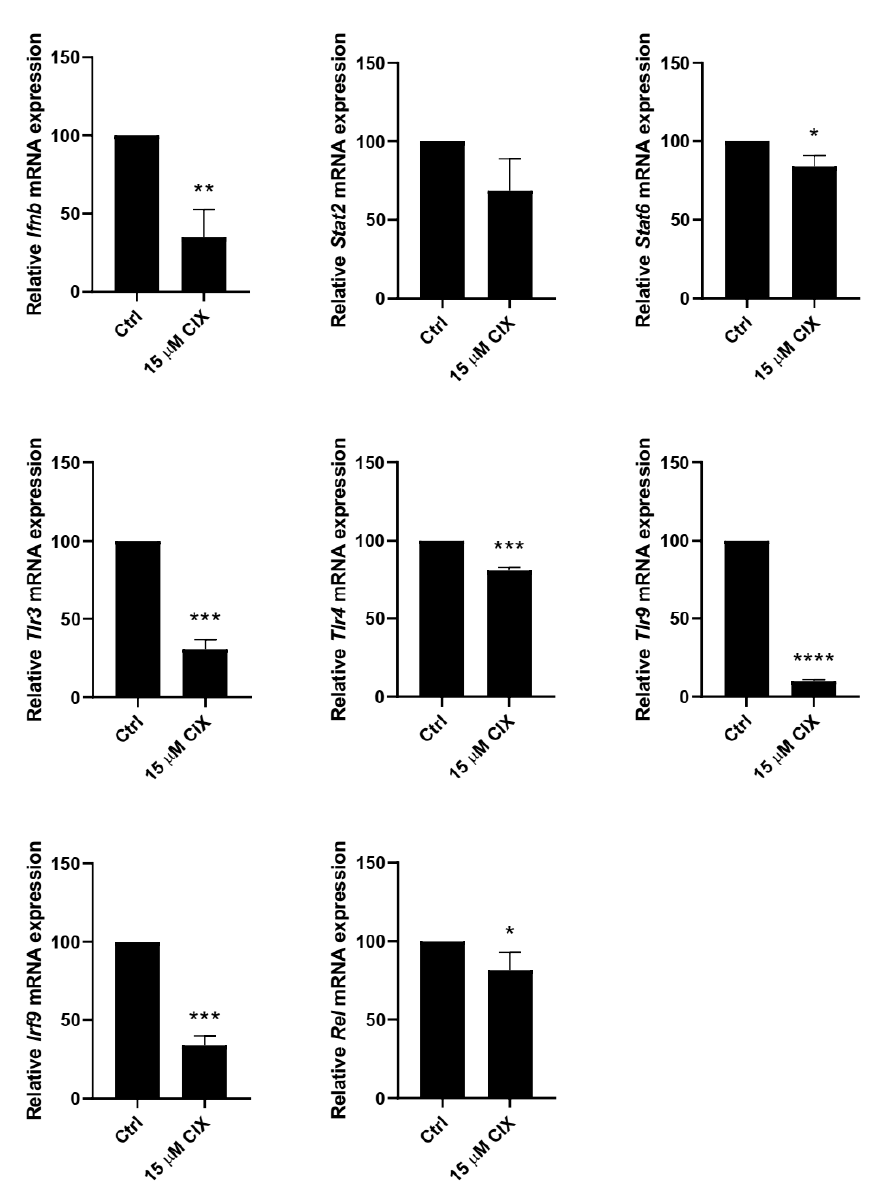
Figure A1. mRNA expression of Ifnb, Stat2, Stat6, Tlr3, Tlr4, Tlr9, Irf9 and Rel in 4T1 cells treated with vehicle or 15 µ M CIX for 24 h. Results shown are mean ± SD of four biologically independent experiments. * p < 0.05, ** p < 0.01, *** p < 0.001, **** p < 0.0001.